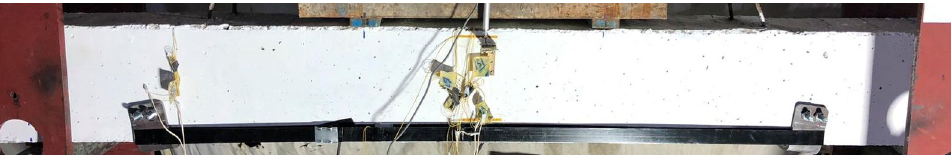
Fig 7. A slight change in the alignment of the